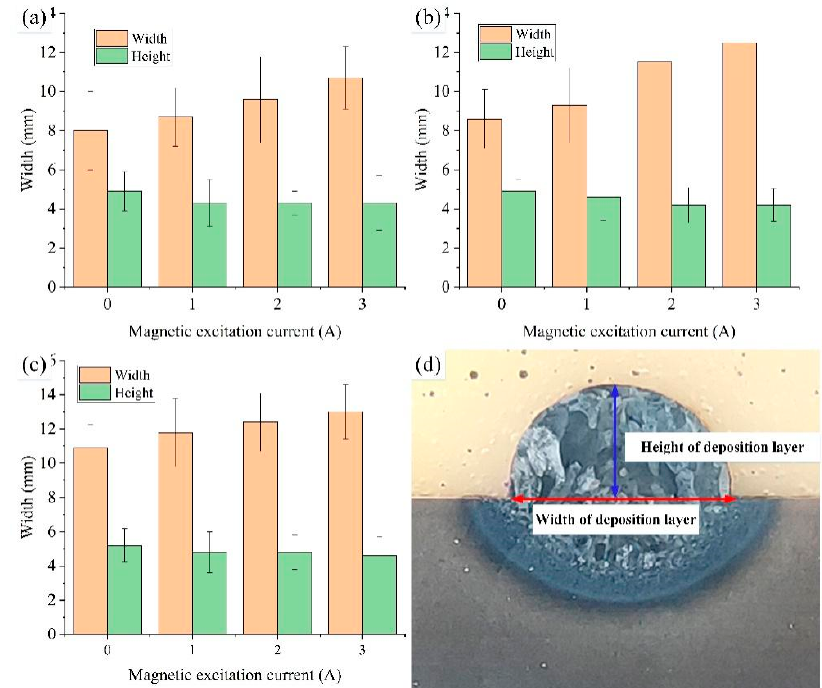
Figure 4. Geometric parameters of cross-sectional of titanium alloy deposited layer under different process parameters: ( a ) Wire feeding speed of 7 m/min, ( b ) Wire feeding speed of 8 m/min, ( c ) Wire feeding speed of 9 m/min, ( d ) Schematic diagram of geometric dimension measurement.